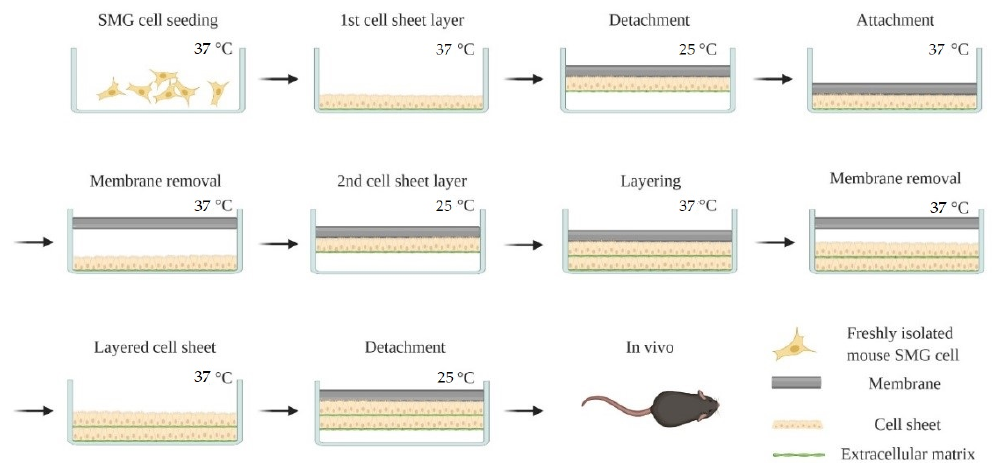
Figure 1. Layered cell sheet preparation process. Created with BioRender.com.